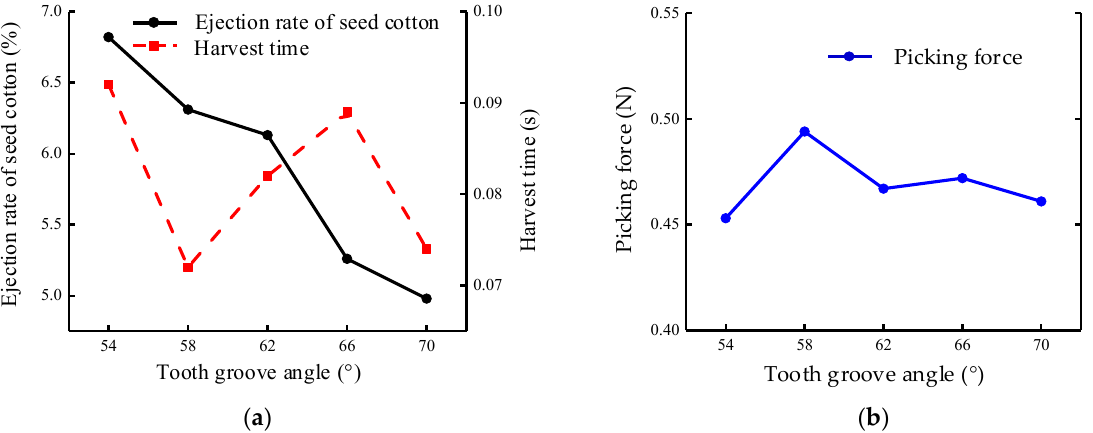
Figure 12. Effect of the tooth angle on the picking performance of the spindle: ( a ) tooth groove angle (ejection rate of seed cotton and harvest time), ( b ) tooth groove angle (picking force).